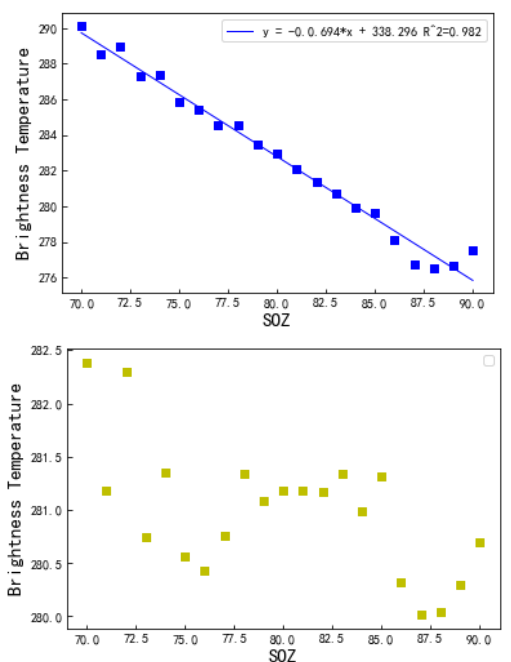
Figure 3. (Top) Linear relationship between brightness temperature of sea fog and solar zenith angle in band 7 (bottom) Relation between brightness temperature of sea fog and solar zenith angle in band 14